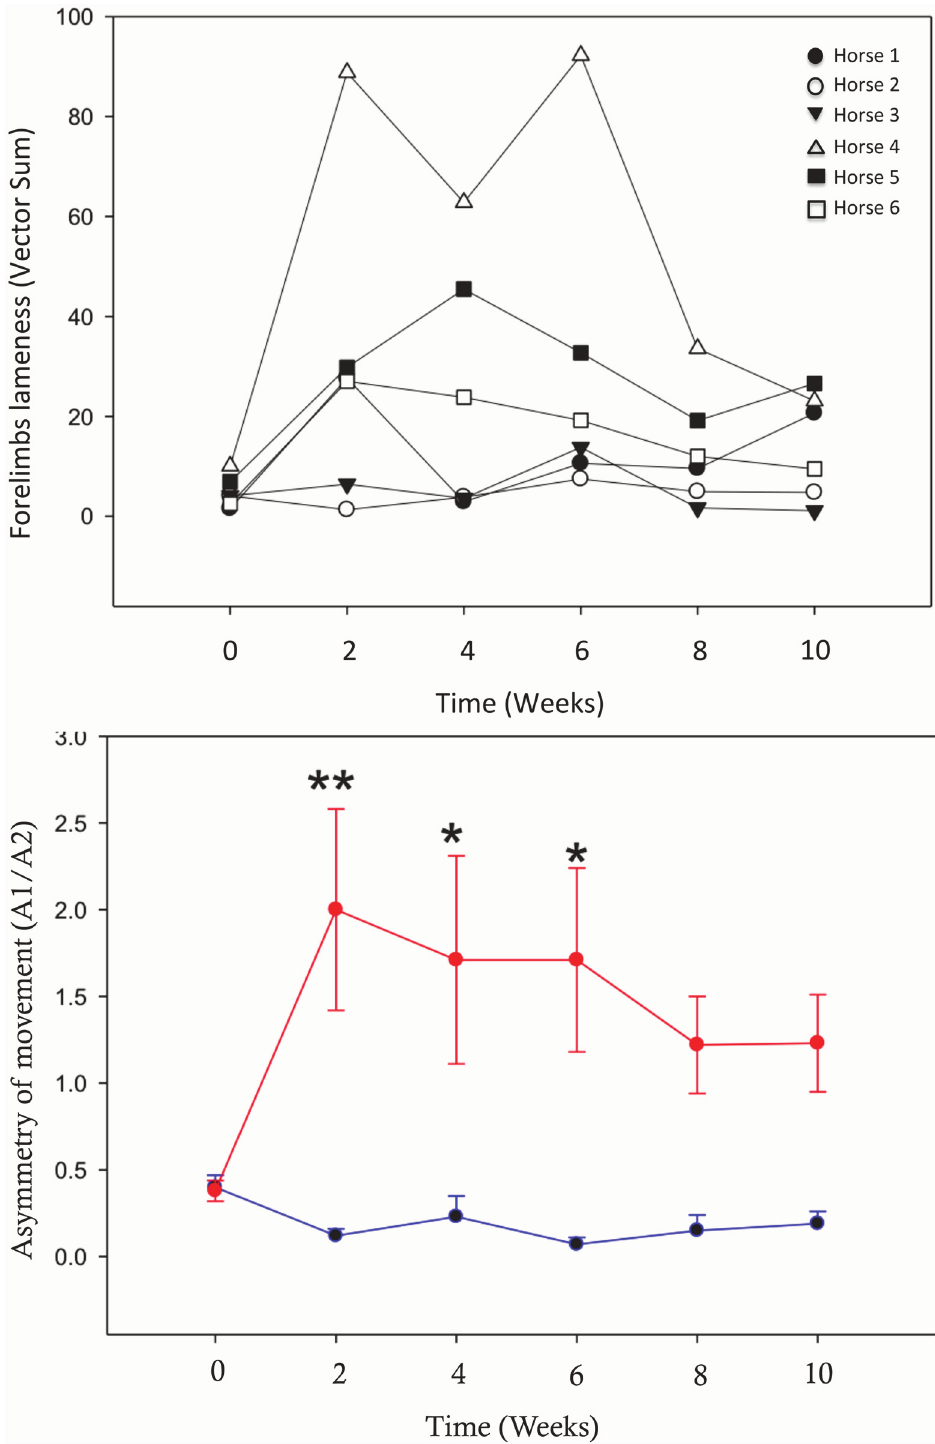
Figure 2. Lameness evaluation with the inertial sensor-based system. (A) Asymmetry of movement of the groove limb (red) as opposed to the sham limb (blue), measured by A1/A2. Mean ± SEM is shown. Asterisks represent significant differences between the groove and sham limbs ( * P < 0.05, ** P < 0.005). (B) Individual time-course of lameness measured by vector